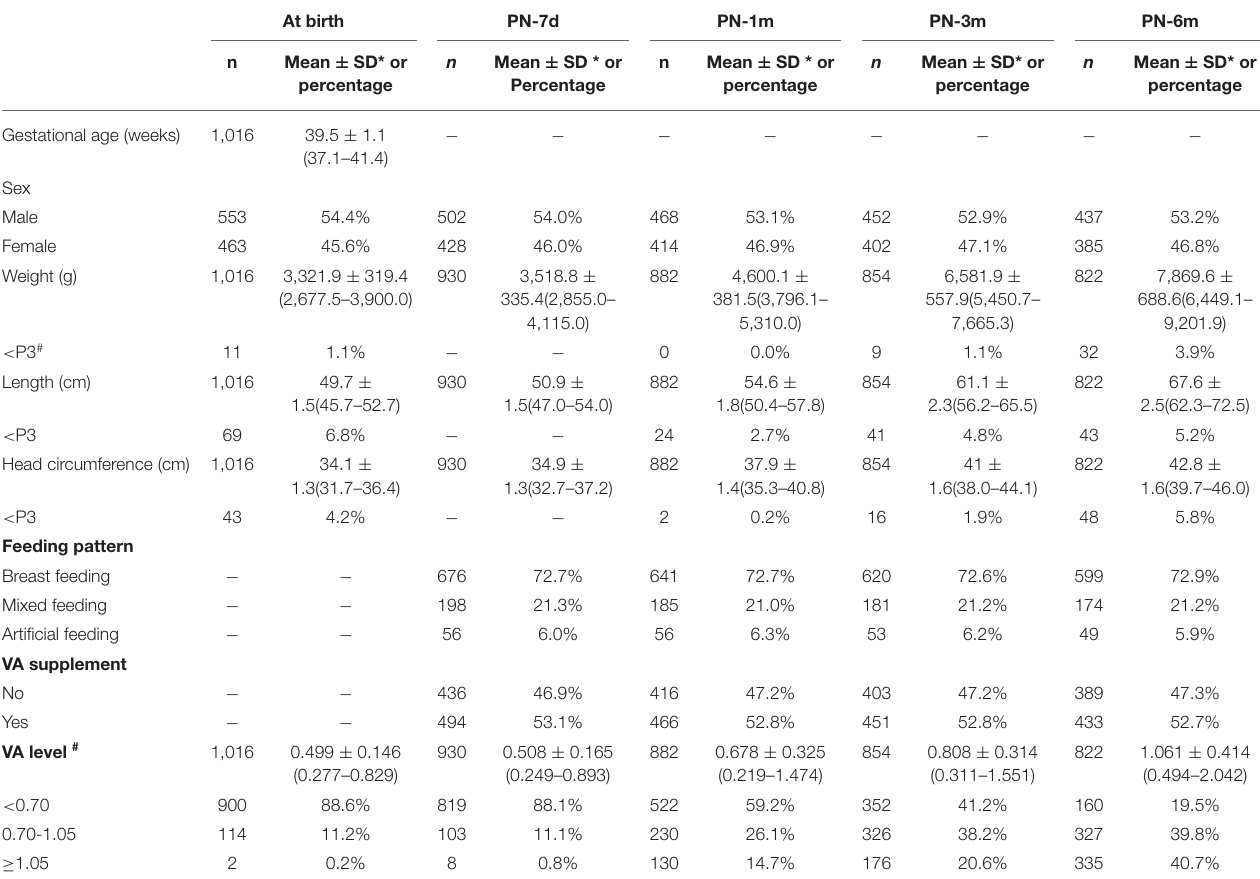
TABLE 1 | Clinical characteristics and VA status of infants during the first 6 months of life in Chongqing, Southwest